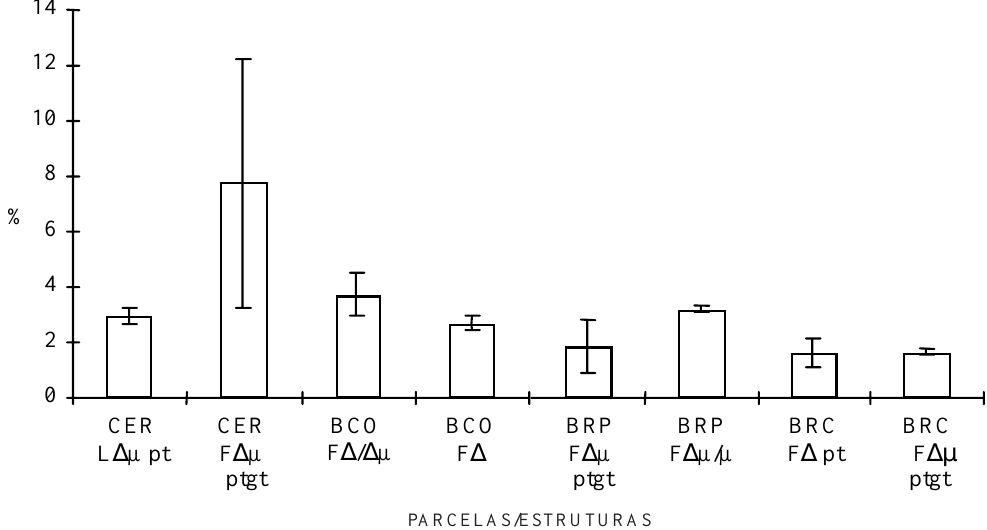
Figura 4. Valores médios e desvios padrões da fração < 0,5 mm, obtidos na peneiragem em água das camadas aráveis (% solo seco